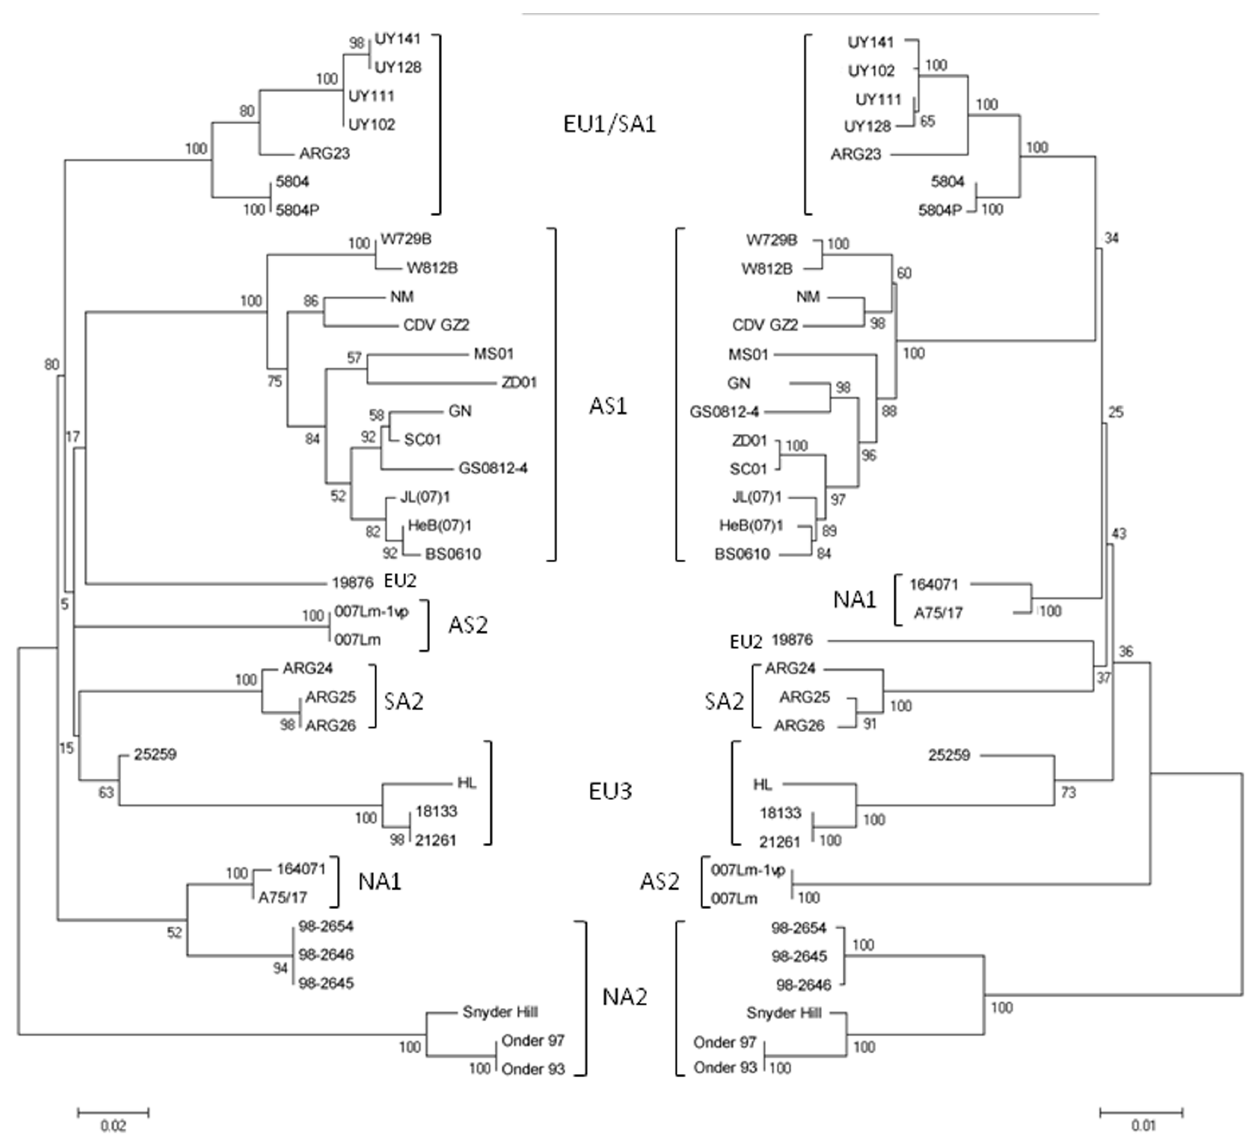
Figure 1. Phylogenetic analysis of CDV isolates. Thirty-seven nucleotide sequences of the Fsp (left) and H (right) datasets were used. Maximum likelihood trees were constructed using the Hasegawa-Kishino-Yano (G) substitution model for both datasets and were inferred through 500 replicates. Branch lengths are measured in the number of substitutions per site, as shown by the scale bars. Unrooted trees were depicted facing each other for comparison. AS1, Asia 1; AS2, Asia 2; EU1/SA1, Europe 1/South America 1; EU2, Europe 2; EU3, Europe 3; NA1, North America 1; NA2, North America 2; SA2, South America 2; Onder, Onderstepoort strain; Snyder, Snyder-Hill strain.